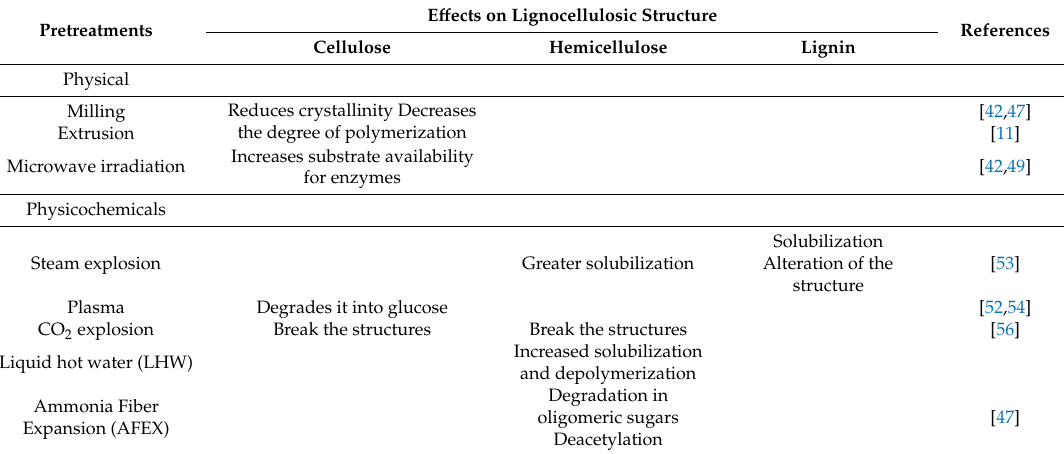
Table 2. Types of pretreatments most used to improve biogas